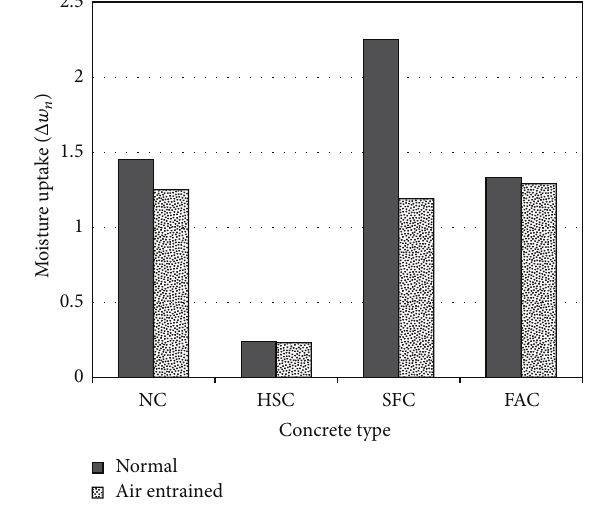
Figure 9: Moisture uptake test results.